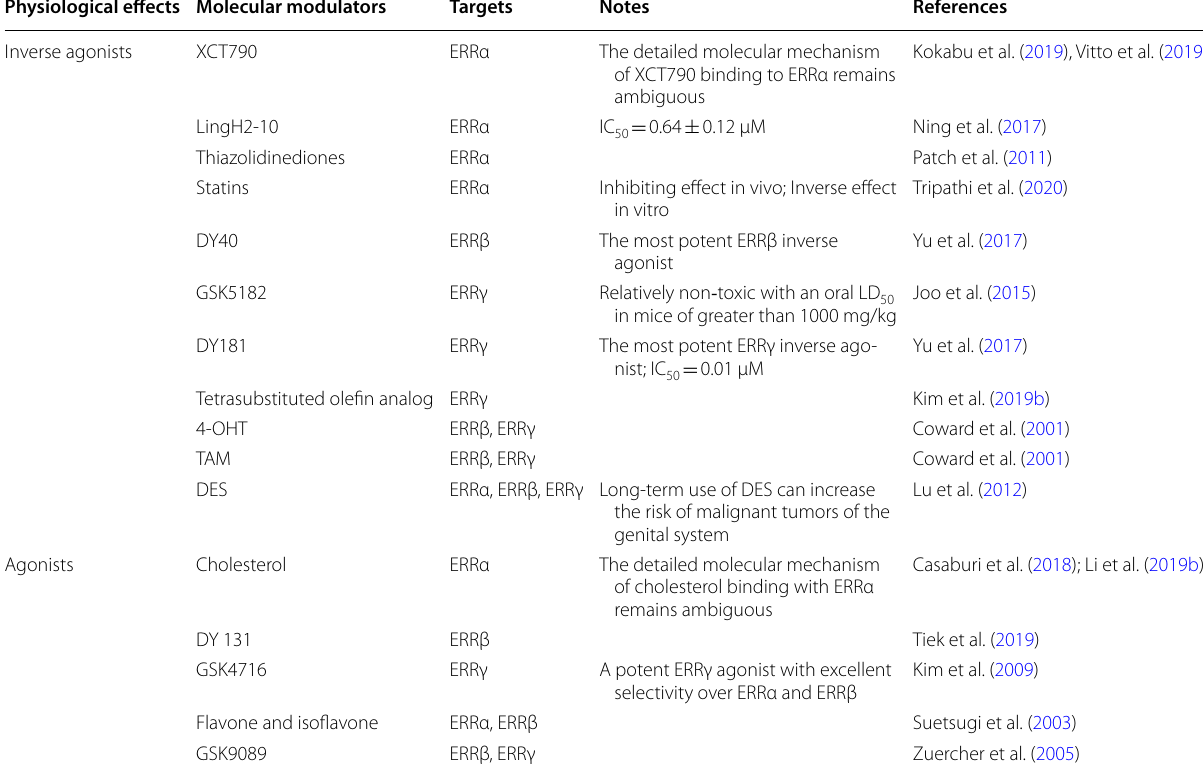
Table 1 Some small molecular modulators of estrogen-related receptors Physiological effects Molecular modulators